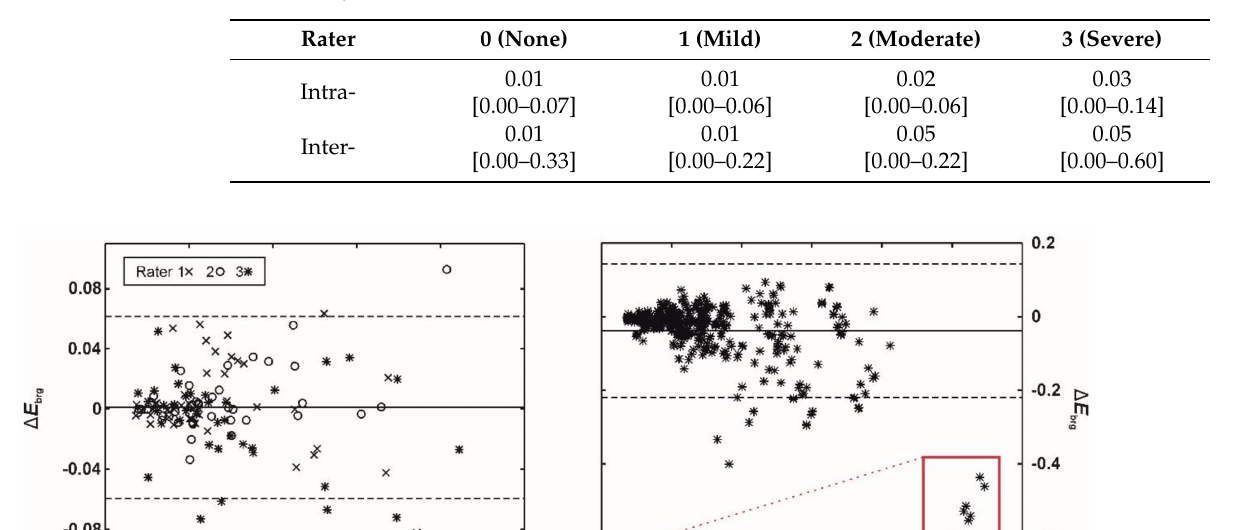
Table 5. Medians (with 2.5 and 97.5 percentiles in squared brackets) of EI BRG misestimates among raters for different erythema severity categories according to the Canine Atopic Dermatitis Extent and Severity Index, fourth iteration (CADESI4) scale.